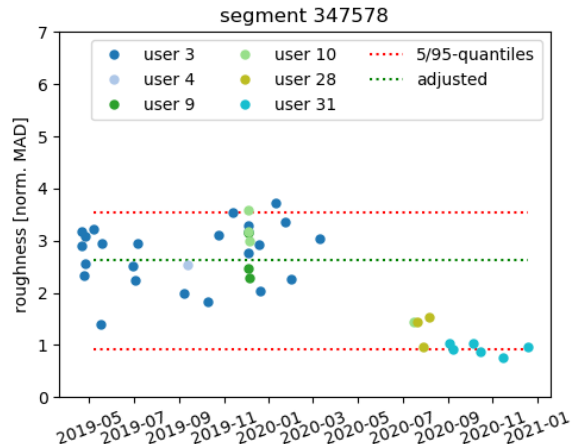
algorithm correctly identifies July 15th as change point